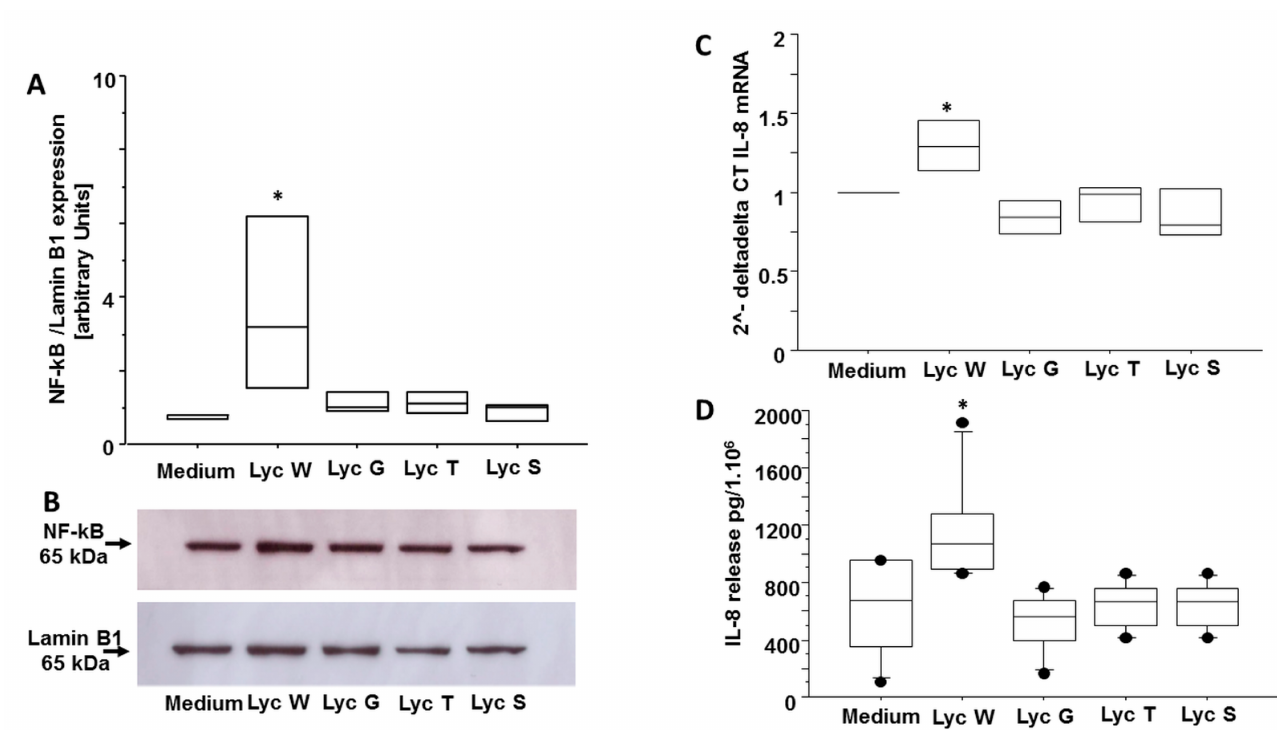
Figure 6. Lyc W affects inflammation markers in A549 cell line. ( A , B ) Lyc W significantly increased nuclear translocation of NF-kB expression in comparison to cells treated with medium and in comparison, to cells treated with Lyc G, Lyc T and Lyc S; ( A ) Three Western blots were semi-quantified by densitometric scanning, normalized and expressed after correction with the density of the bands obtained for housekeeping proteins for nuclear proteins. Data are expressed as arbitrary units. The results are shown as box-plots with medians (lines inside the boxes). Analysis of variance (ANOVA), Fisher’s PLSD, n = three experiments; *, p -value < 0.05. ( B ) representative Western blot for NF-kB and for the nuclear housekeeping gene Lamin B1; ( C , D ) Lyc W significantly increased both m-RNA ( C ) and IL-8 protein expression ( D ) in comparison to cells treated with medium and in comparison, to cells treated with Lyc G, Lyc T and Lyc S. The results are shown as box-plots with medians